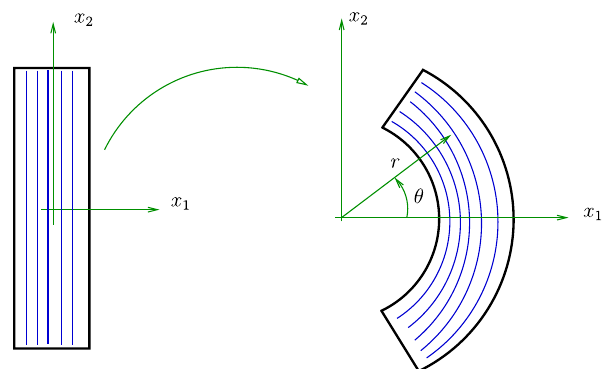
Figure 3. Bending of a rectangular block into a sector of a cylindrical